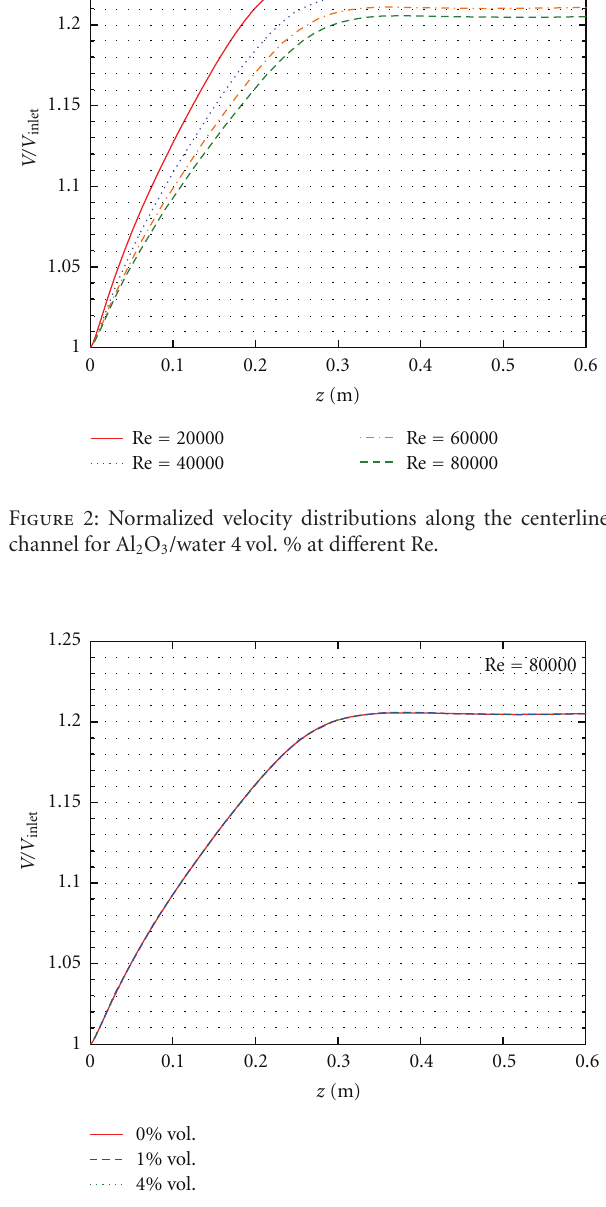
Figure 3: Normalized velocity distribution along the centerline of channel for Re = 80 × 10 3